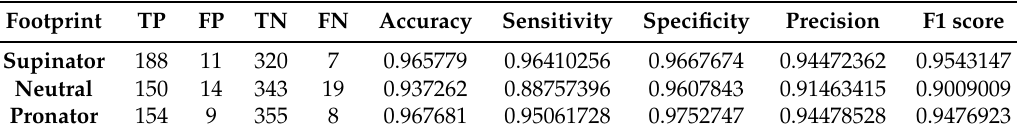
Table 5. Classification results for the real-time test.